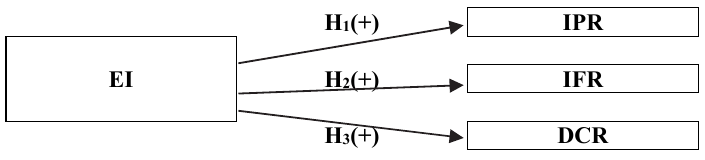
Fig. 1. The Relationship between Emotional Intelligence and Managerial Roles (Source: Authors’ own